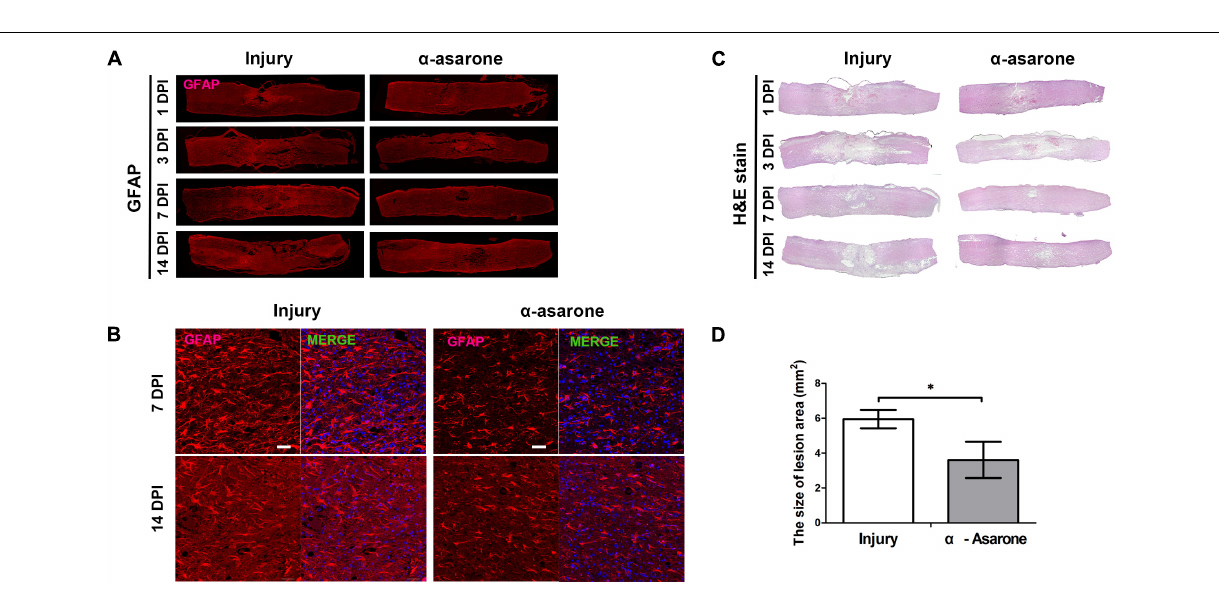
Frontiers in Pharmacology |